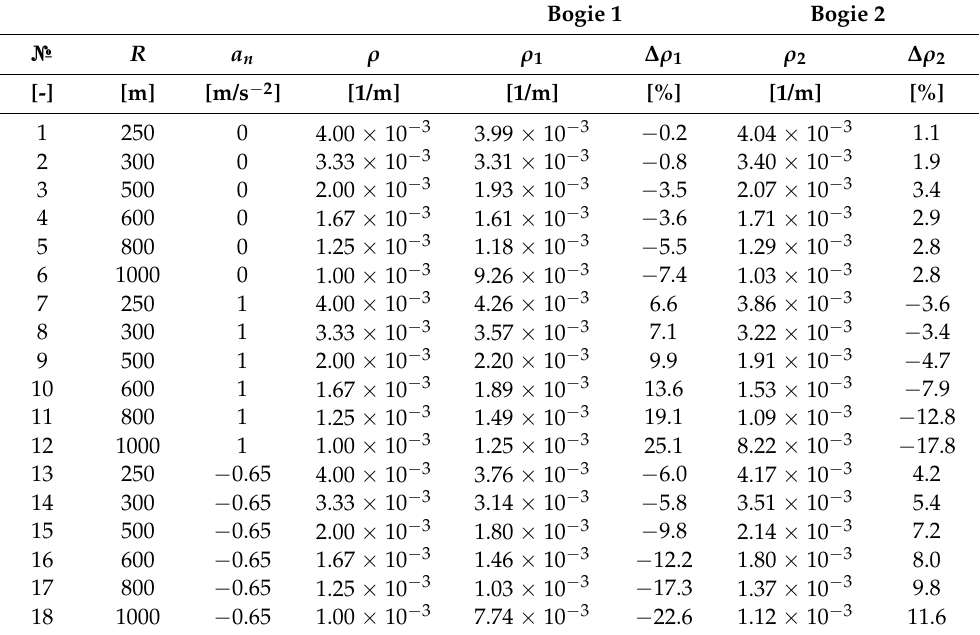
Table 5. Calculated track curvature using Formula (5).